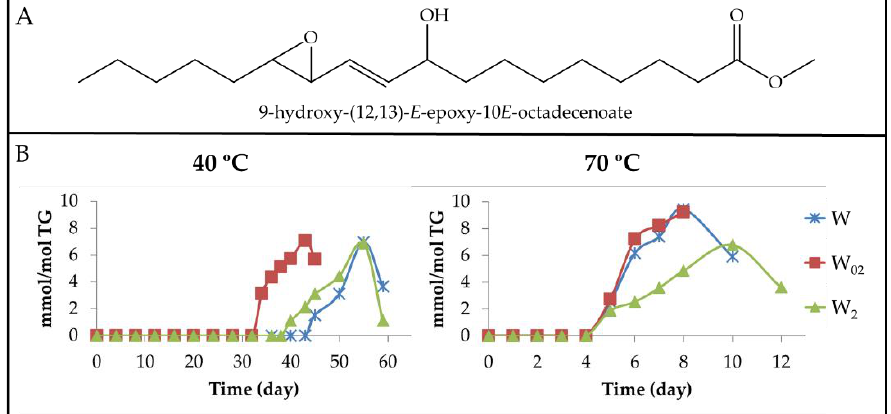
Figure 9. ( A ) Structure of 9-hydroxy-(12,13)- E -epoxy-10 E -octadecenoate as an example of non-vici- nal mHO-mEPO- E -mE. ( B ) Evolution of the concentration expressed as mmol/mol TG, of the non-vicinal mHO-mEPO- E -mEs in walnut oil with different enrichment levels in αT (W, W 02 and W 2 ), submitted to either 40 °C or 70 °C up to advanced stages of the oxidation process.